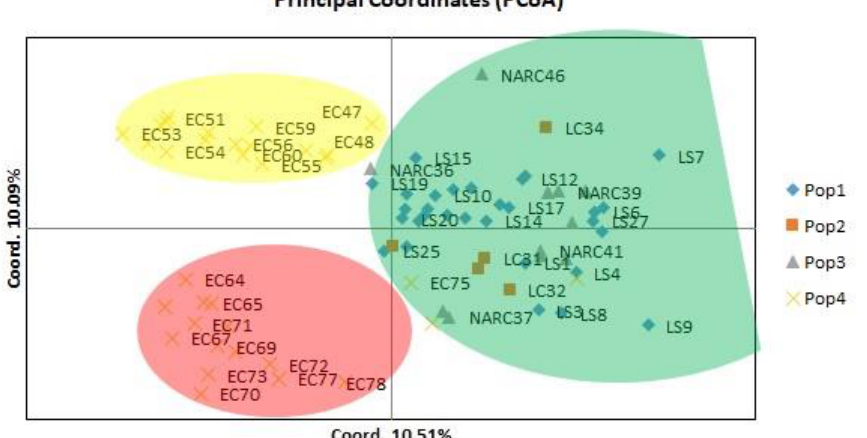
Figure 2. Principle coordinate analysis of 80 potato genotypes indicated the 20.6% variation based on retrotransposon markers; population 1 represents local strains, population 2 represents local cultivars, population 3 represent NARC cultivars, and population 4 represents exotic cultivars. Genetic distance was calculated using the dissimilarity index for constructing a NJ tree using 11 iPBS markers. Among the local strain (LS) population, LS9 (22.74) and LS3 (19.72) revealed the highest genetic distance. Among the local cultivar (LC) population,